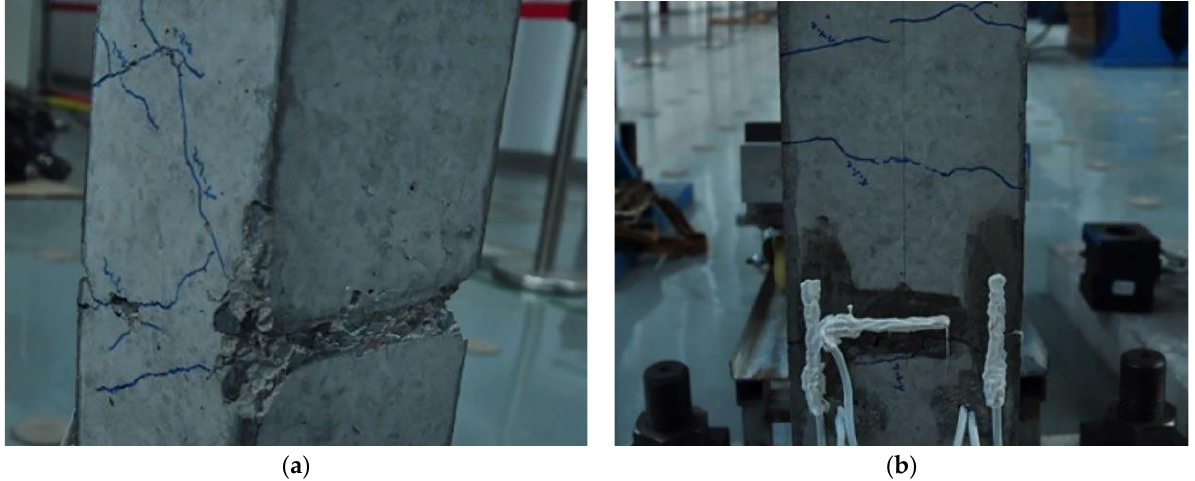
Figure 7. Damage area of C_2: ( a ) concrete cracks at the impact contact position and ( b ) concrete cracks at the backside of the contact position.